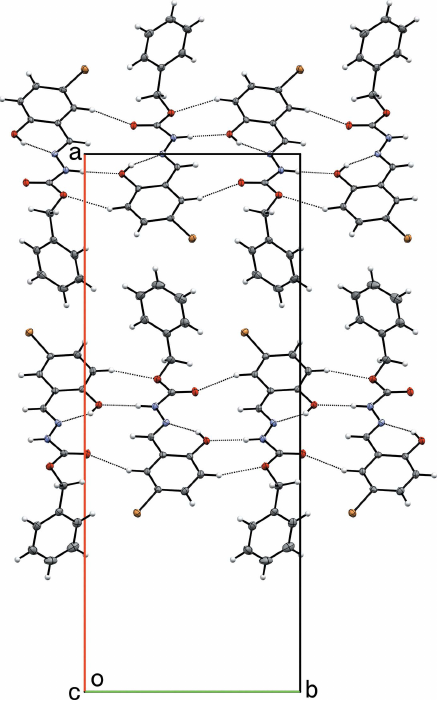
Figure 6 A partial packing plot of II showing N—H (cid:2)(cid:2)(cid:2) O and C—H (cid:2)(cid:2)(cid:2) O hydrogen- bonded ribbons along [010] of II A (upper) and II B (lower) molecules.